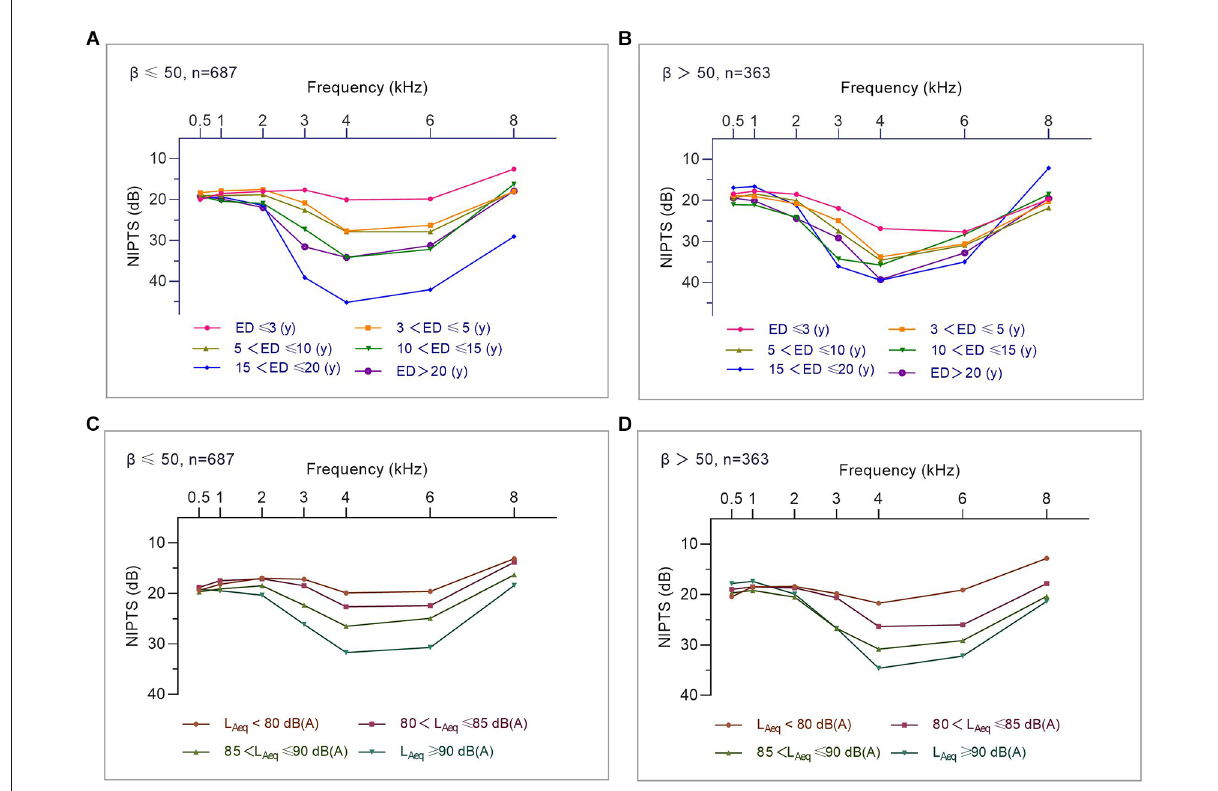
FIGURE5 The influence of kurtosis on the association of average NIPTS curves for manufacturing workers with noise exposure duration and noise intensity. (A) Average NIPTS curves of workers with different noise exposure duration when β ≤ 50. (B) Average NIPTS curves of workers with different noise exposure duration when β > 50. (C) Average NIPTS curves of workers exposed to noise at different L Aeq.8h levels when β ≤ 50. (D) Average NIPTS curves of workers exposed to noise at different L Aeq.8h levels when β >